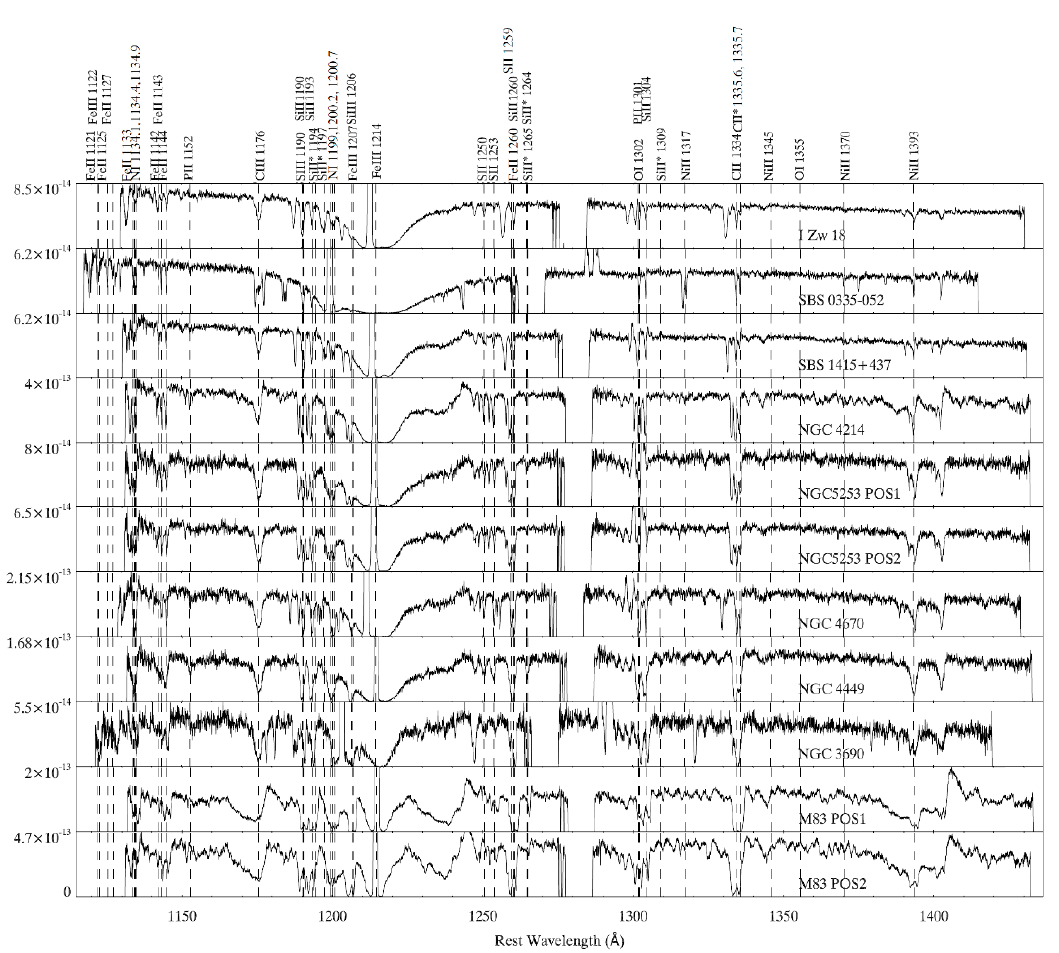
Figure 10. COS G130M spectra of the star clusters seen in the images in Figure 9. The spectra are arranged in order of increasing oxygen abundance from top to bottom. The major absorption lines in each galaxy are labeled in the uppermost panel. From [32].